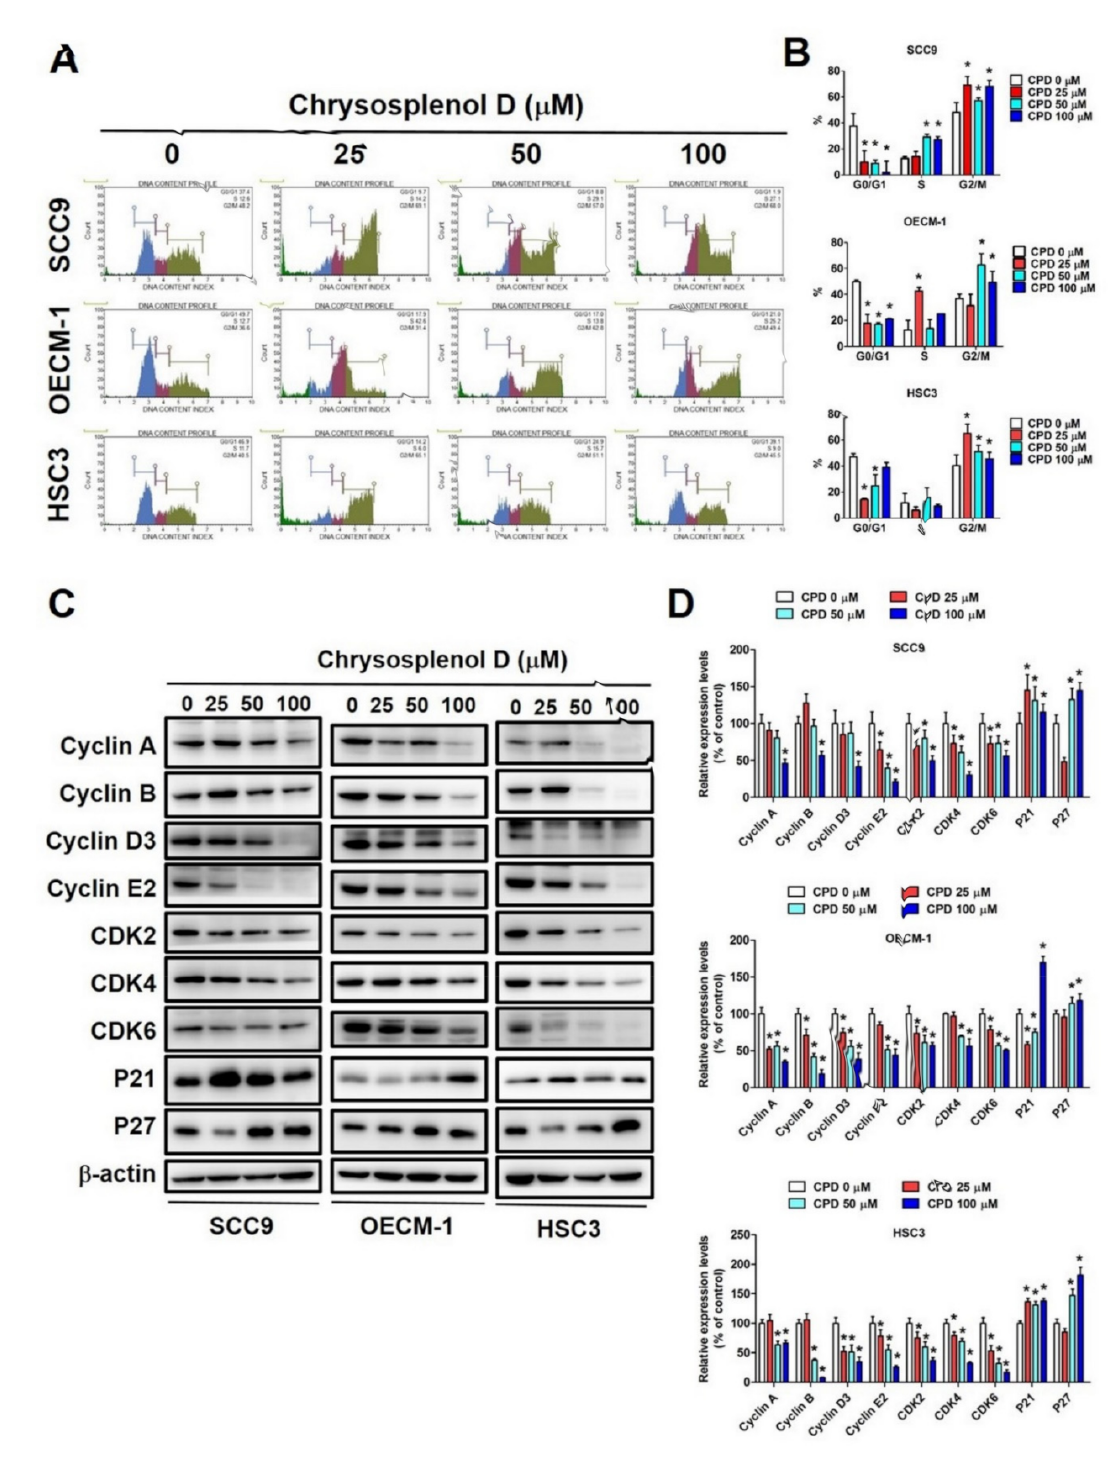
Figure 2. Chrysosplenol D induced cell cycle arrest in the G 2 /M phase in oral squamous cell carcinoma (OSCC) cell lines. ( A , B ) After the treatment of SCC-9, OECM-1, and HSC-3 cells with chrysosplenol (0, 25, 50, and 100 µ M) for 24 h, cell cycle phase distribution was analyzed through flow cytometry after propidium iodide (PI) staining. Graphs show the findings of statistical analysis. ( C , D ) The expression levels of cell cycle-regulating proteins, namely cyclin A, cyclin B, cyclin D3, cyclin E2, CDK2, CDK4, CDK6, p21 and p27, were detected through Western blot analysis after chrysosplenol D treatment for 24 h. The β -actin protein level was used to adjust quantitative results. Graphs show the findings of the statistical analysis of cell cycle-regulating proteins. Data are presented as the mean ± SD from three independent experiments * p < 0.05 compared with the vehicle treatment